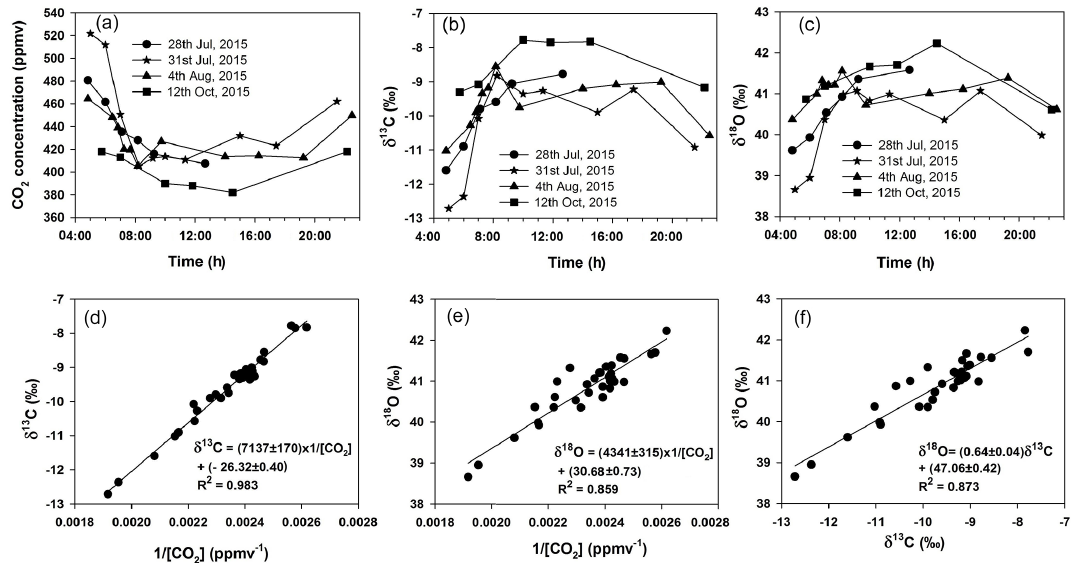
Figure 2. Diurnal variation of (a) concentration, (b) δ 13 C and (c) δ 18 O of CO 2 sampled in the greenhouse. Keeling plots for (d) δ 13 C and (e) δ 18 O and (f) scatter plot of δ 13 C and δ 18 O to show their